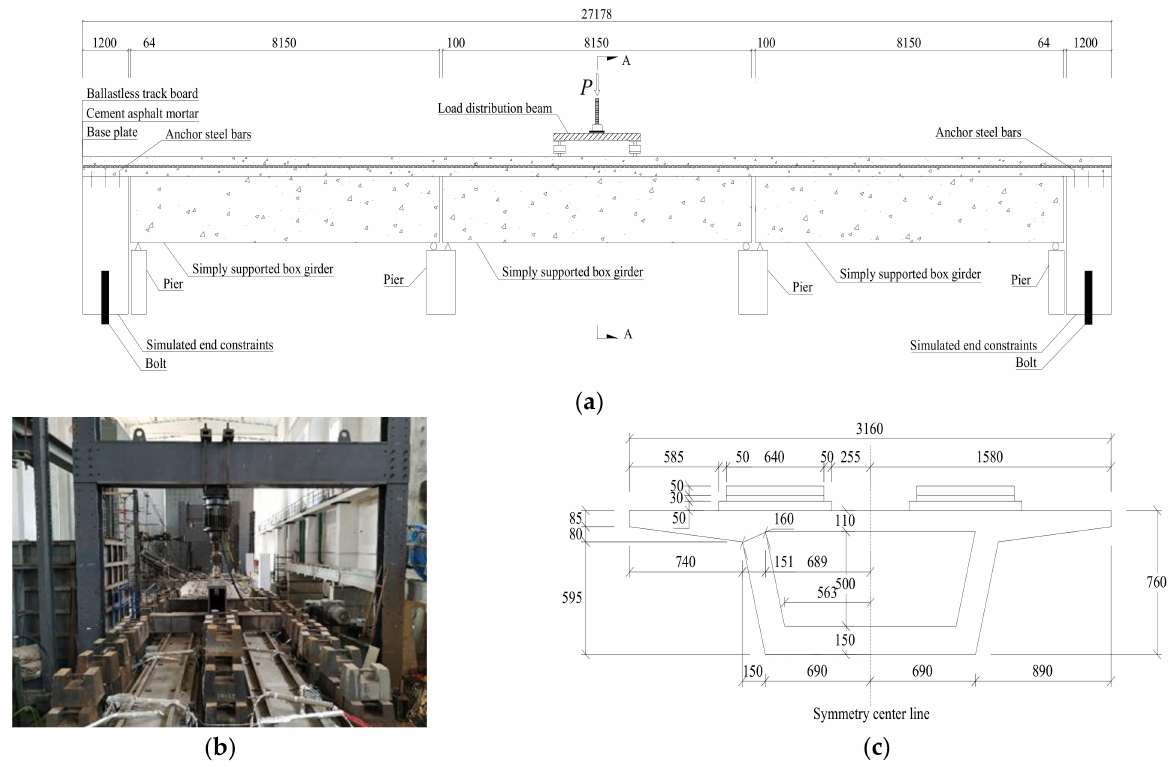
Figure 1. Track–bridge specimen: ( a ) Elevation chart of three-span test girder bridge (unit: mm); ( b ) top view of the specimen; ( c ) section A: Cross section at mid span (unit: mm).